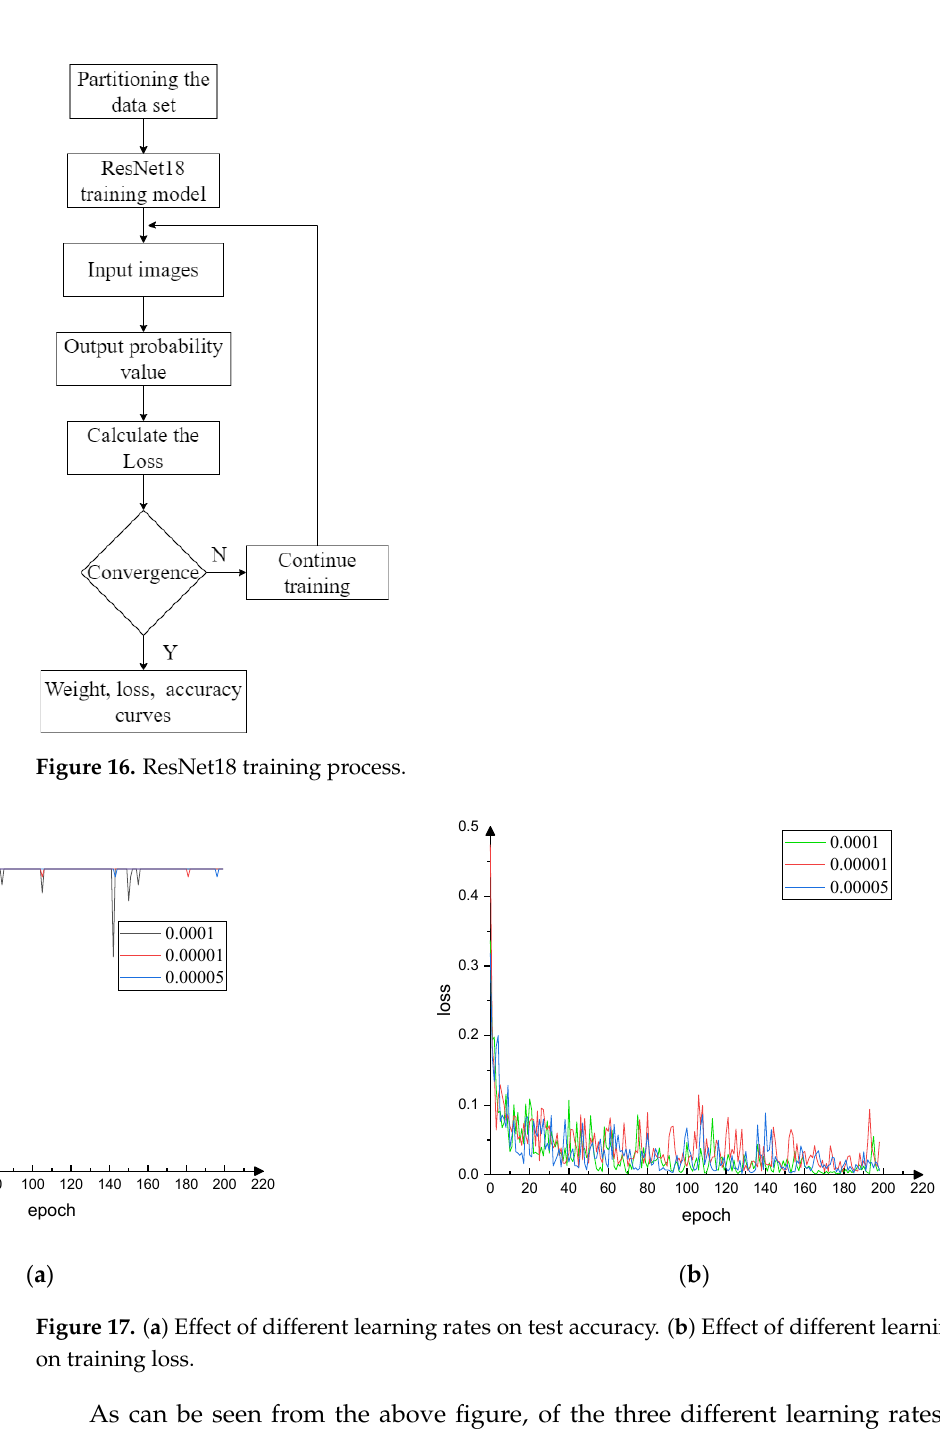
Figure 17. ( a ) Effect of different learning rates on test accuracy. ( b ) Effect of different learning rates on training loss.